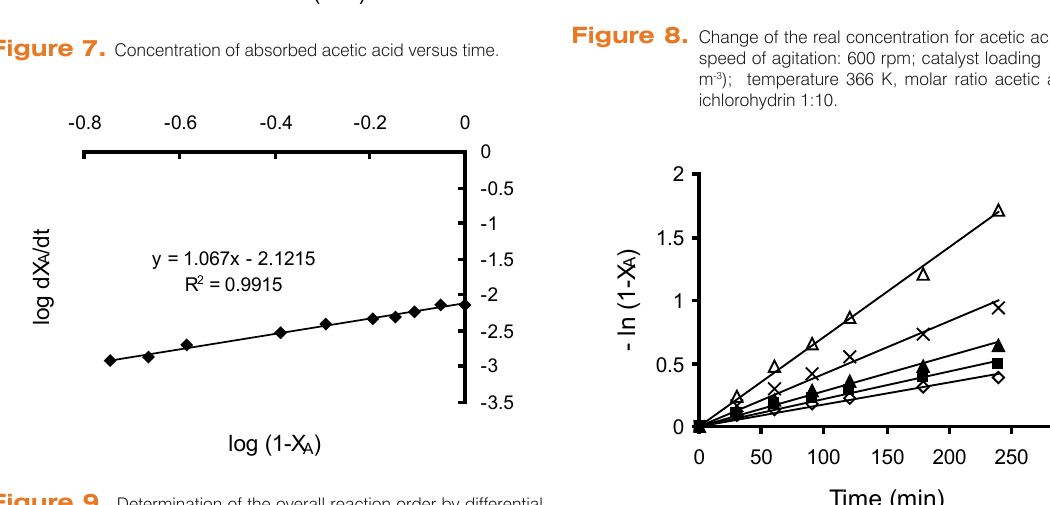
Figure 9. Determination of the overall reaction order by differential method.